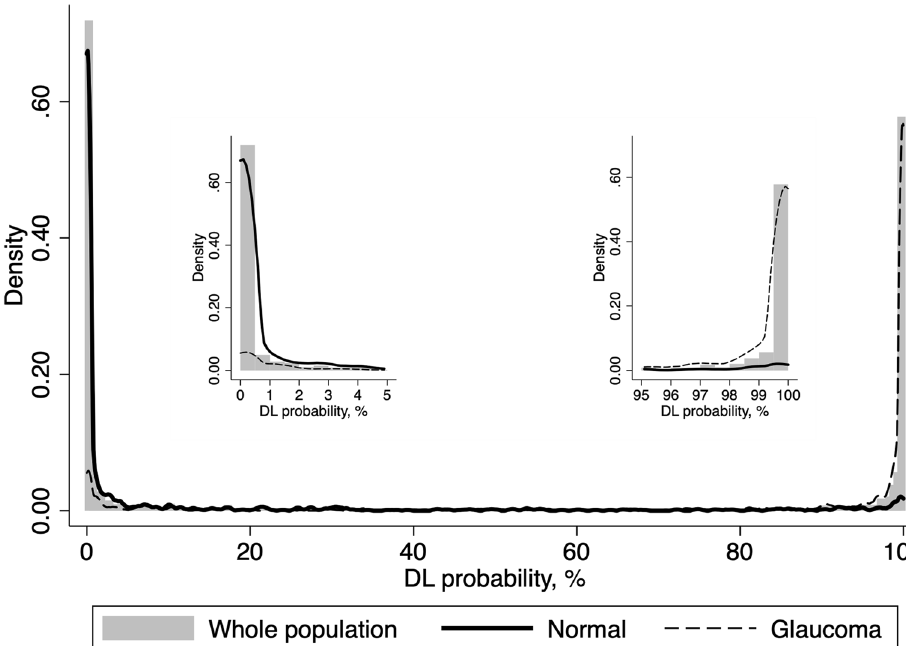
Figure 1. Distribution of the deep learning (DL) probabilities of glaucoma for the photos included in the test sample. The overall distribution is represented by shaded bars. Tails of the distribution (left, low probability of glaucoma; and right, high probability of glaucoma by the DL algorithm) are shown in detail. Photos classified as normal by the objective criteria proposed in the study had DL probabilities of glaucoma concentrated closer to zero (solid line). For photos classified as glaucoma, the DL probabilities were concentrated closer to one hundred (dotted line). DL deep